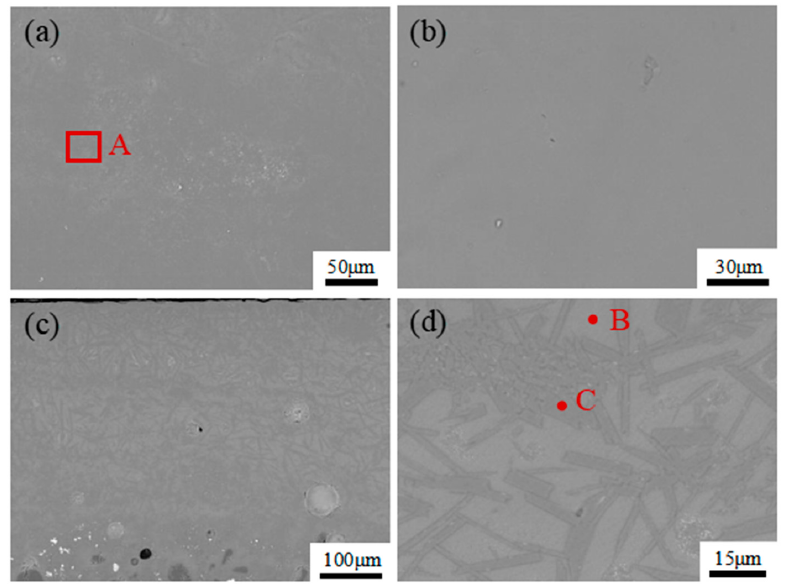
Figure 7. SEM images of grey-glazed porcelain (JZ-16) with di ff erent magni fi cation: ( a , b ) surface morphology; and ( c , d ) the polished cross-section morphology.